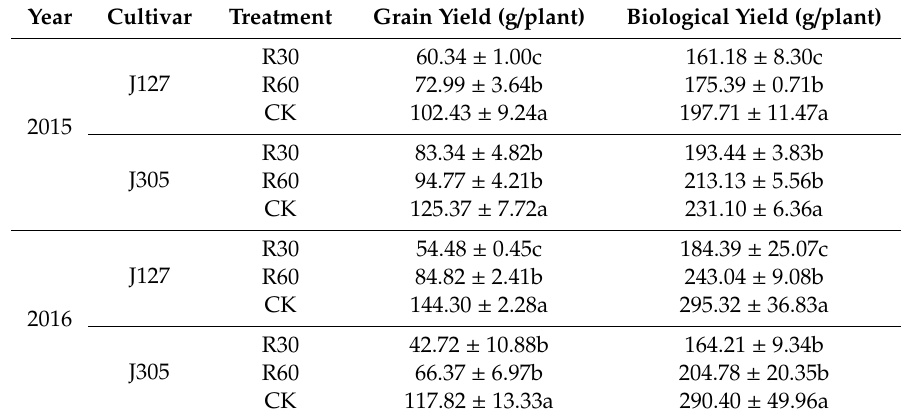
Table 4. E ff ects of root removal in di ff erent soil depths on grain and biological yield in 2015 and